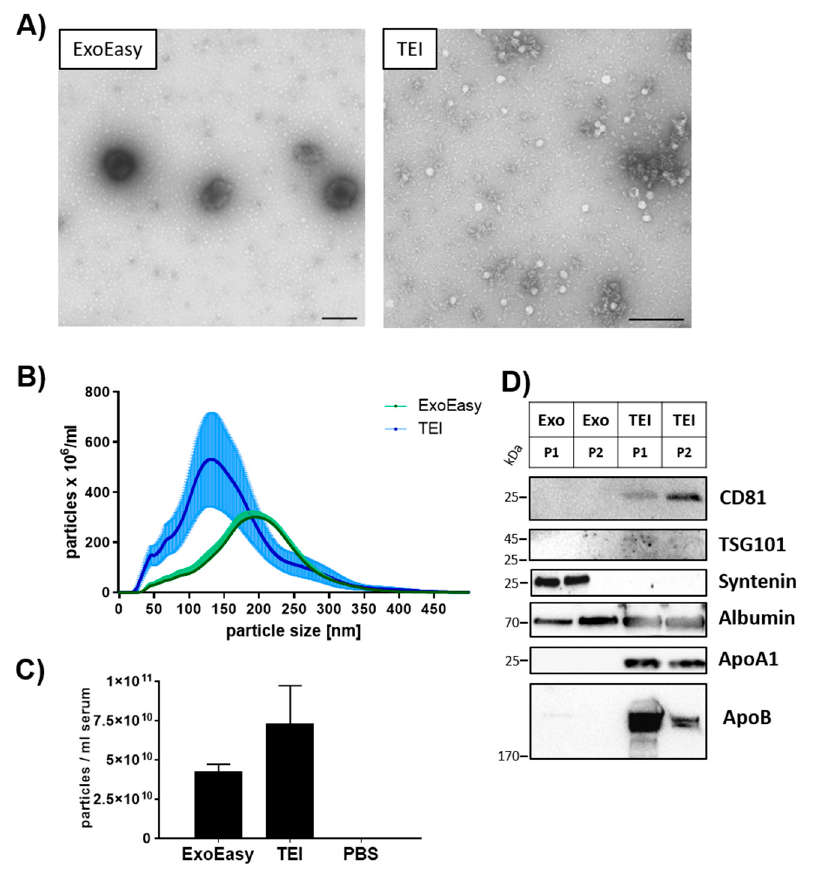
Figure 1. Characterization of extracellular vesicles. EVs were isolated by either membrane affinity (ExoEasy) or precipitation (TEI) methods. ( A ) Transmission electron microscopy was utilized to analyze morphology of isolated particles; scale bar = 200 nm. ( B ) The size profile of particles was assessed by nanoparticle tracking analysis (NTA) (mean and SEM of n = 4 individuals). ( C ) The total amount of particles from NTA in ( B ) was calculated. ( D ) Western blot analysis determined the presence of EV-associated markers and contamination with lipoproteins and soluble proteins. Serum from two healthy individuals (P1, P2) was used for EV isolation. A total of 20 µg total protein was loaded onto the gel.